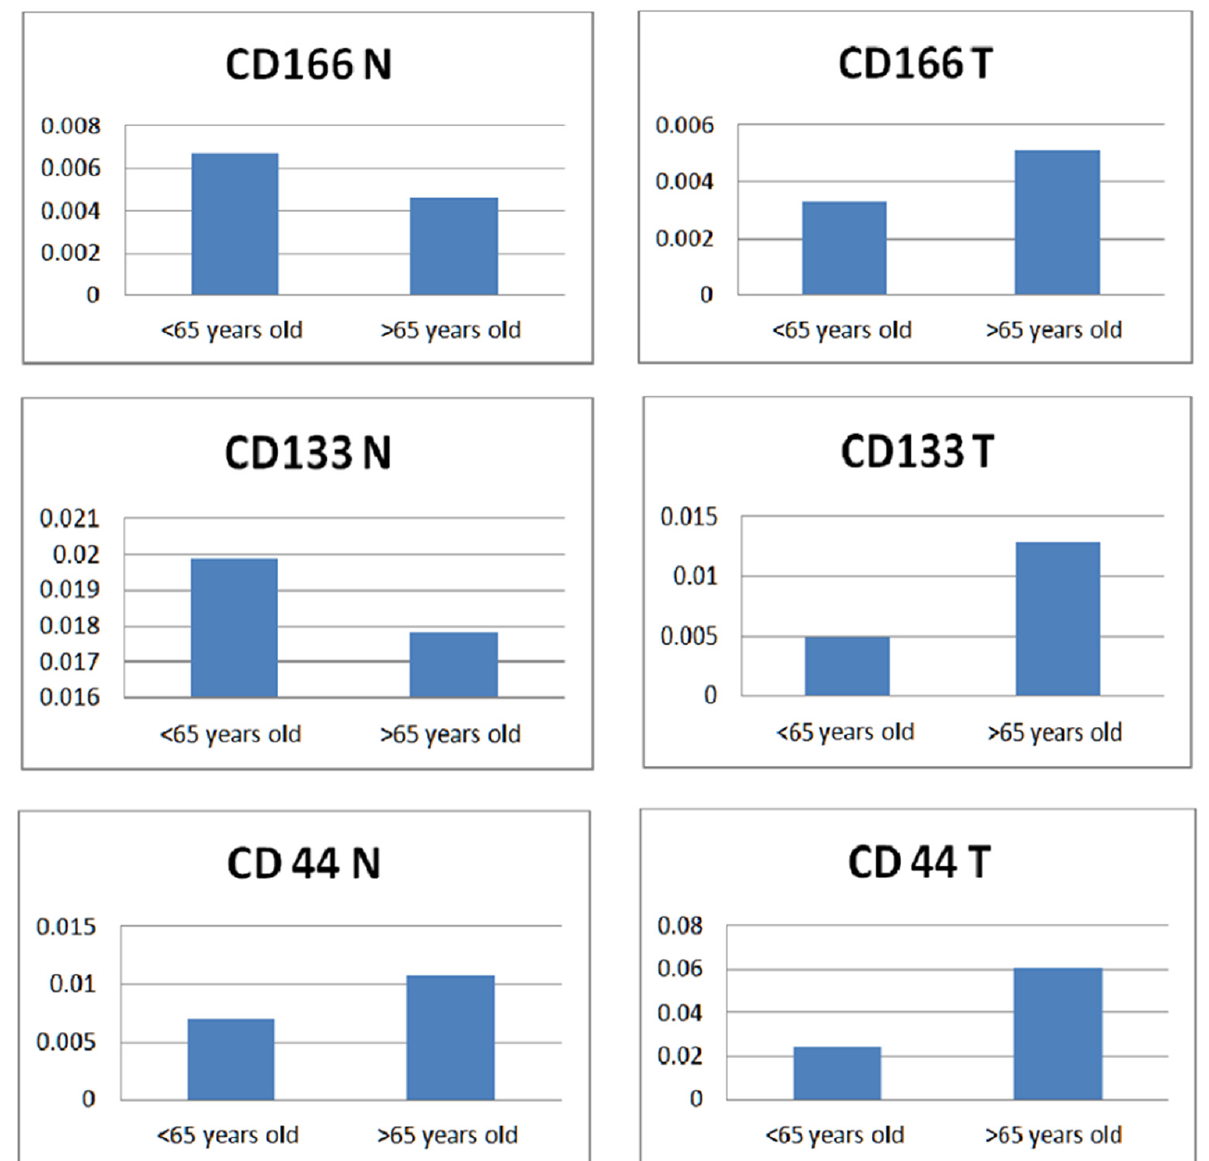
Figure 4. Normal versus tumor tissue expression of the three markers according to age. A non-parametric Mann–Whitney test was used to compare individual groups, and all values achieved statistical significance ( p < 0.05).